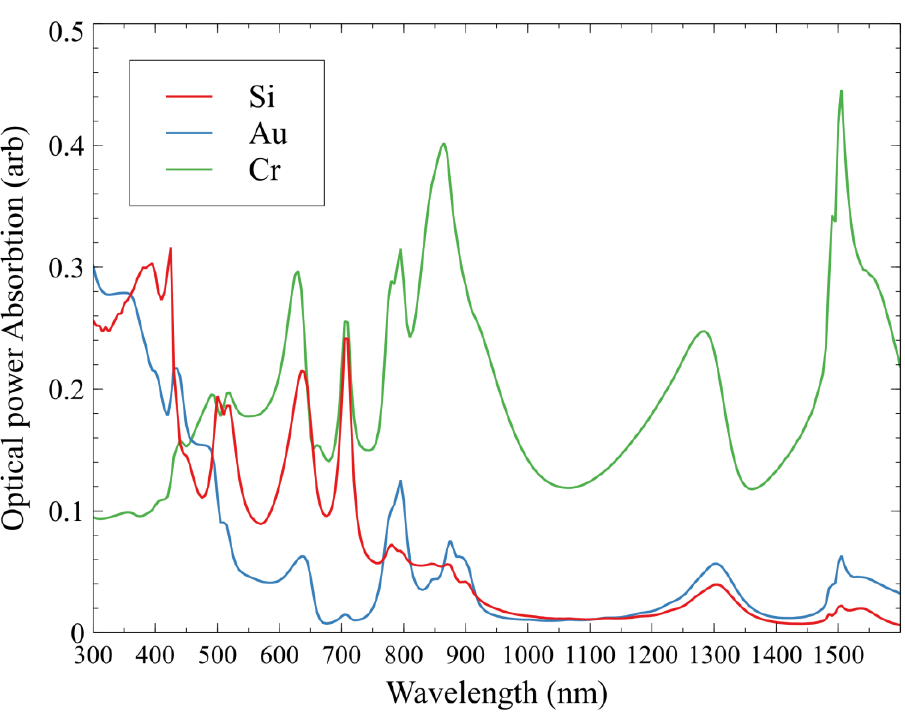
Figure 3. Optical power absorption spectra with a duty cycle of 73.5%. The power absorption of silicon grating, Cr metal layer, and Au metal contact is shown.